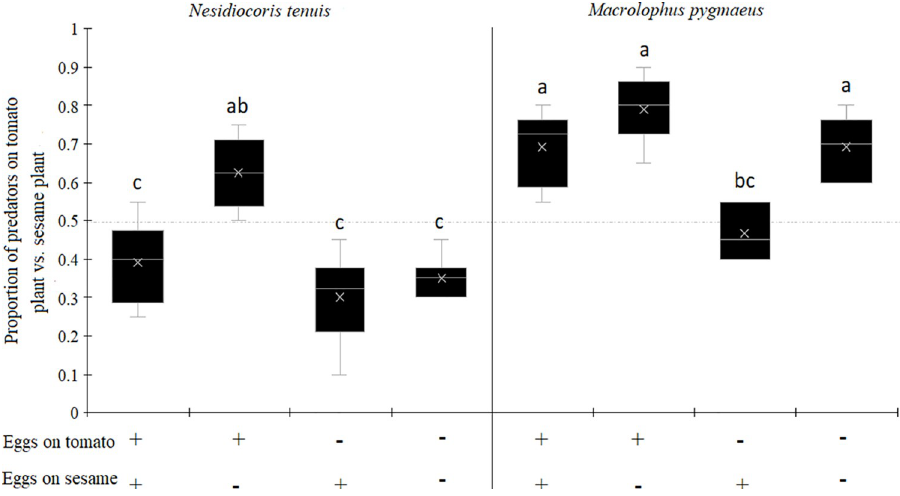
Fig 3. Proportion of predators ( Nesidiocoris tenuis or Macrolophus pygmaeus ) on tomato vs sesame plants according to the presence or absence of Ephestia kuehniella eggs on the tomato or the sesame plant. The ‘+’ indicates the presence and the ‘-’ indicates the absence. Boxplot followed by the same lower case letter did not differ